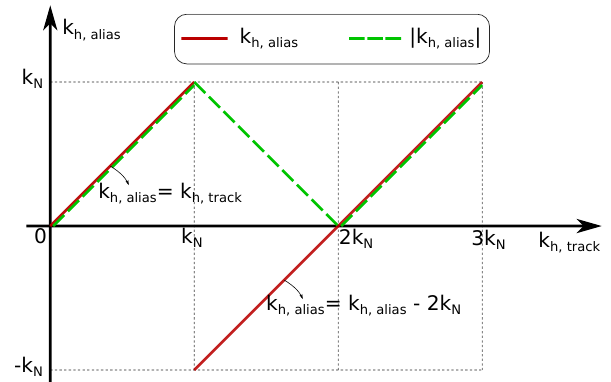
Figure 9. “Alias” wave number vs. wave number along tangent- point